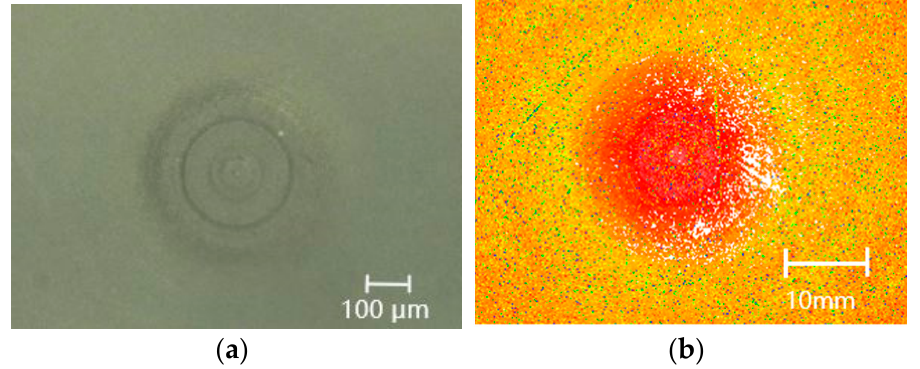
Figure 5. Periodic ring breaking. ( a ) Results of the super depth-of-field microscope. ( b ) Results of the white light interferometer.